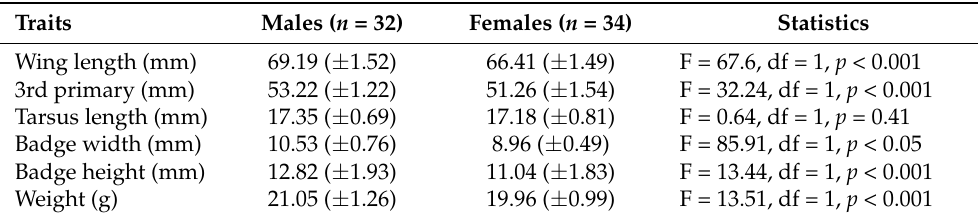
Table 1. Values (mean ± SD) of the morphometric variables registered in male and female Eurasian Tree Sparrows, and one-way ANOVA statistics of the comparison between sexes. Traits Males ( n = 32) Females ( n = 34)